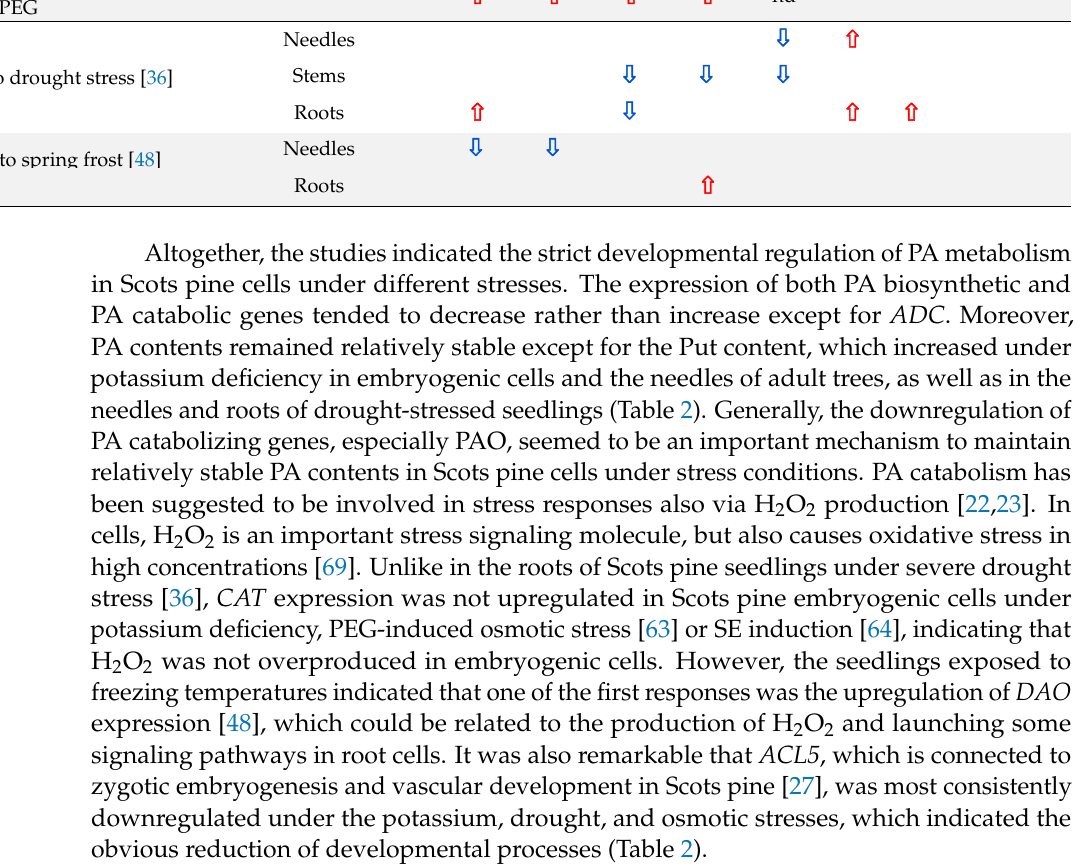
Table 2. Summary of PA metabolism in Scots pine under potassium deficiency, drought, and cold stresses.